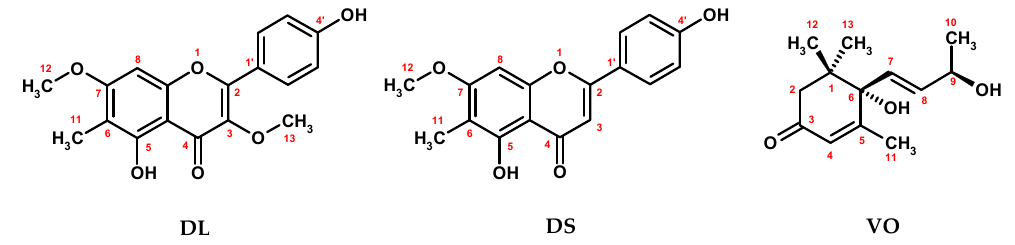
Figure 1. Structures of compounds DL , DS and VO isolated from G. procumbens chloroform extract.